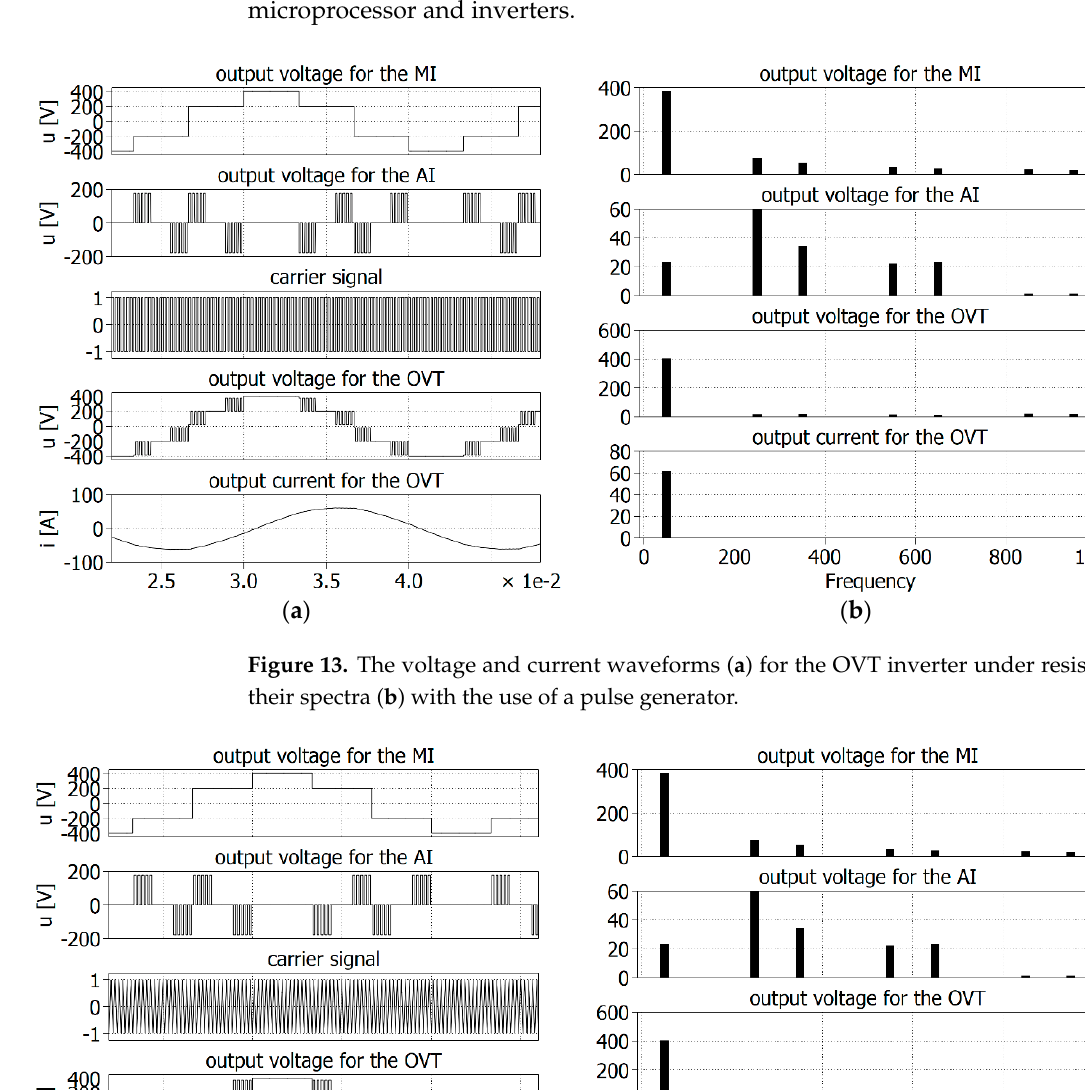
Figure 12. OVT inverter models including the implementation of modified control systems for the auxiliary inverter for the variant when a pulse generator ( a ), triangular generator ( b ), and PWM generator ( c ) are used.